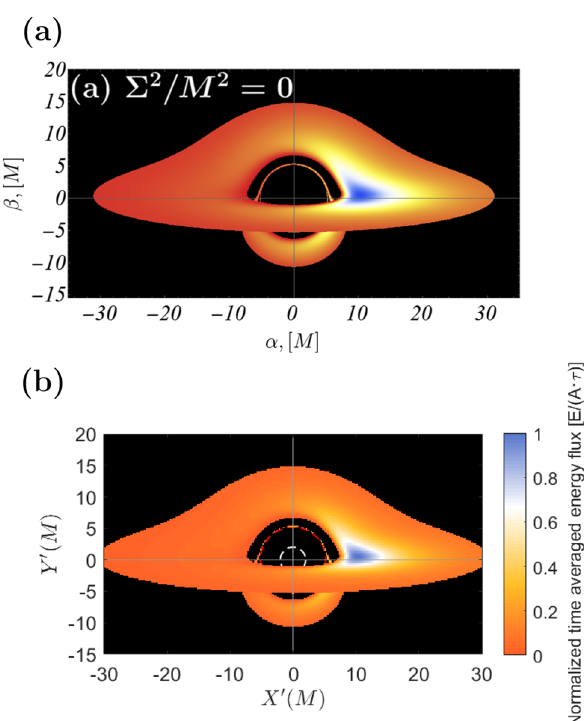
Fig. 7 Apparent image of a Schwarzschild BH surrounded by a thin accretion disk. We set the BH mass M = 1, r s = 2, r skyph = 60 r s (computational domain limit or infinite), (cid:14) L p = r s / 10, d plate = 40 r s , r i = 3 r s (internal radius of the accretion disk), r e = 15 r s (external radius of the accretion disk), and θ o = 80 ◦ (inclination angle of the observer). The red and white dashed circles represent the photon sphere radius projected at infinity (BH shadow), and the BH event horizon r s , respectively. The lateral colored scale represents the normalized time averaged energy flux of matter present in the accretion disk. Panel a : Apparent numerical image of a Schwarzschild BH provided by Igor Bogush [26], where (cid:17) is a coupled scalar field. The vertical and hori- zontal axes: β , and α , represent the projection of the BH image on the observer’s sky. Panel b : Result obtained with our approach. Credits for textures used in this image to